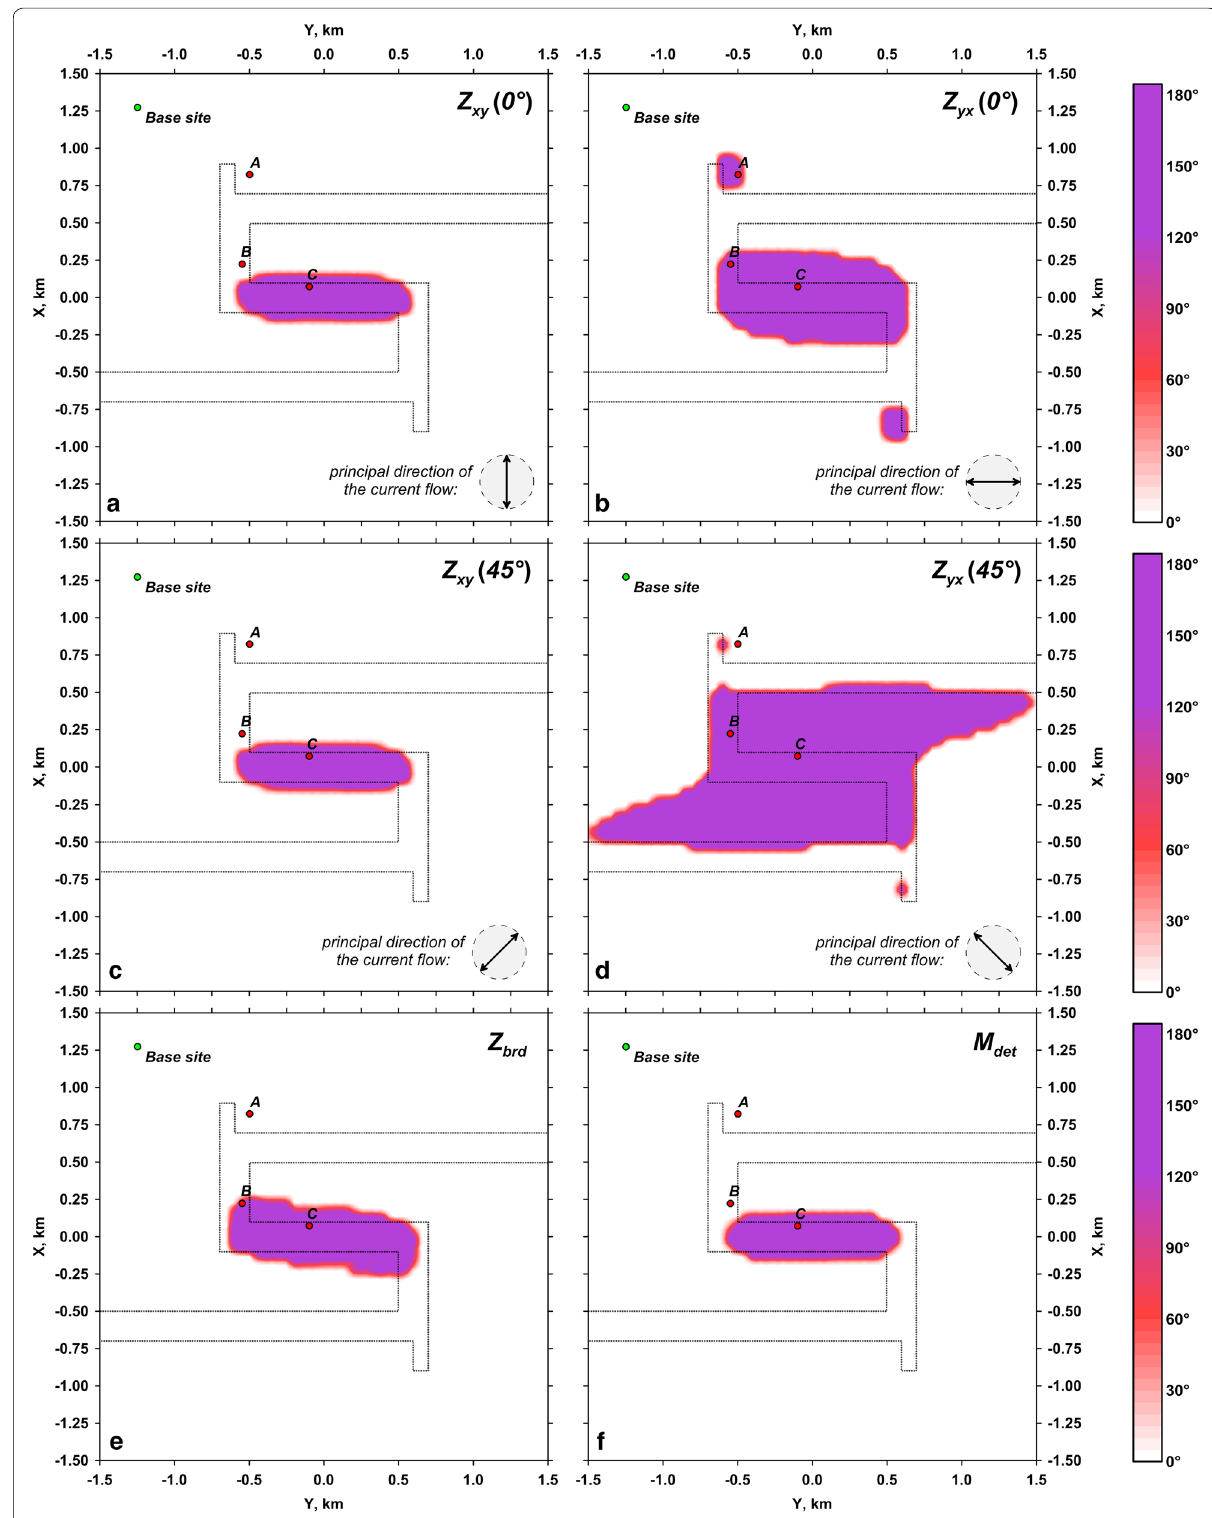
Fig. 12 Maps of maximum absolute DR-II violation within the period range from 10 − 3 s to 10 3 s for various MT functions. Green dot marks out the location of the reference site used for calculation of the inter-site tensors ˆ M , ˆ Q and ˆ S ; red dots show the MT sites to be considered separately (see Figs. 13,